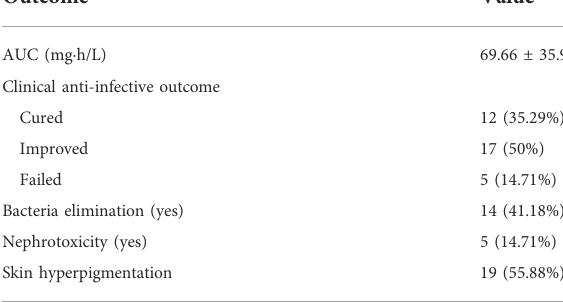
TABLE 2 Total outcomes of recipients with lung